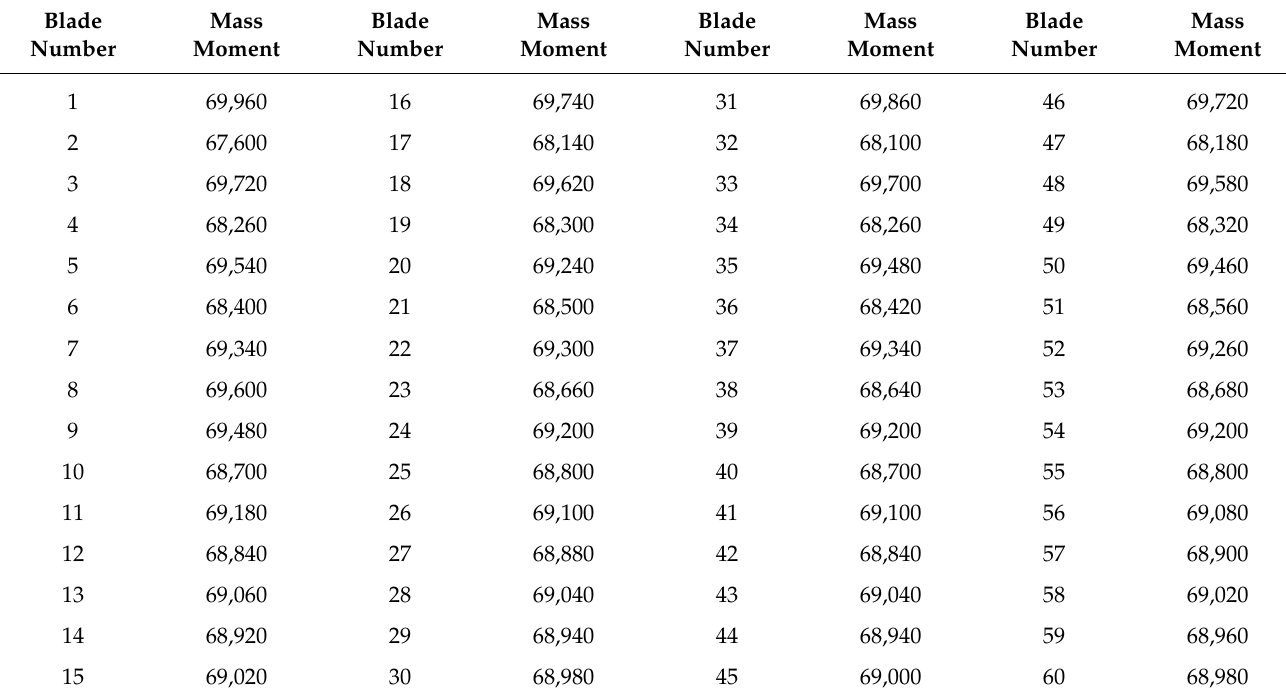
Table 3. Second-level blade